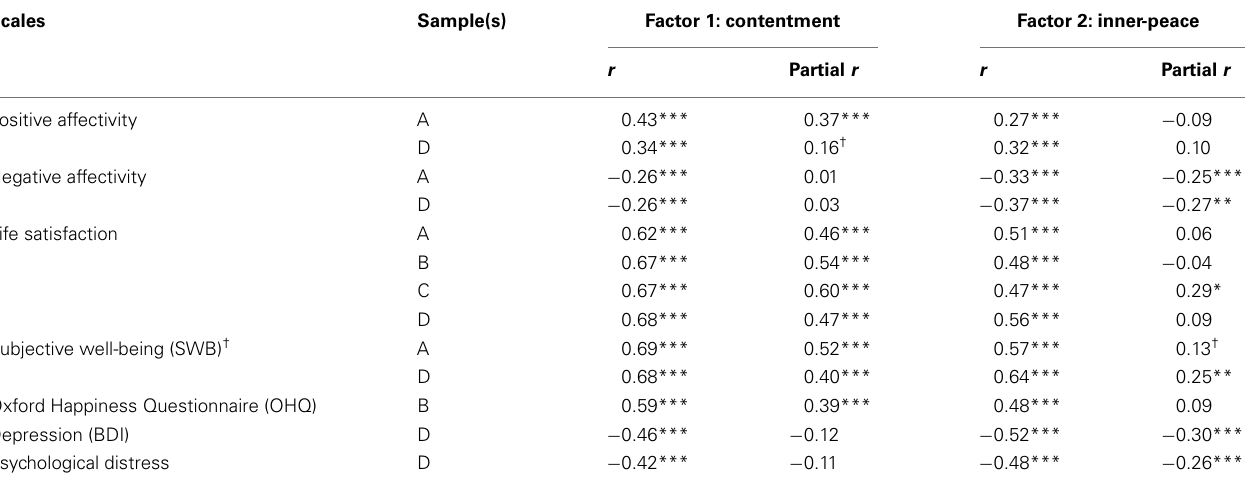
Table 6 | Correlations of the two components of SubjectiveAuthentic–Durable Happiness (i.e., contentment and inner-peace) with various measures of well-being, happiness, and mental health.